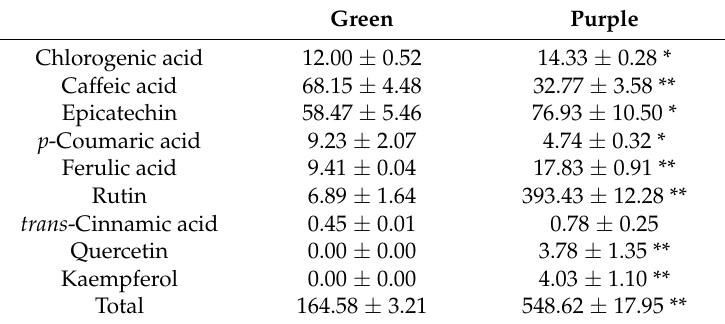
Table 1. Phenylpropanoid contents in green and purple pakchoi ( μ g g − 1 dry weight).